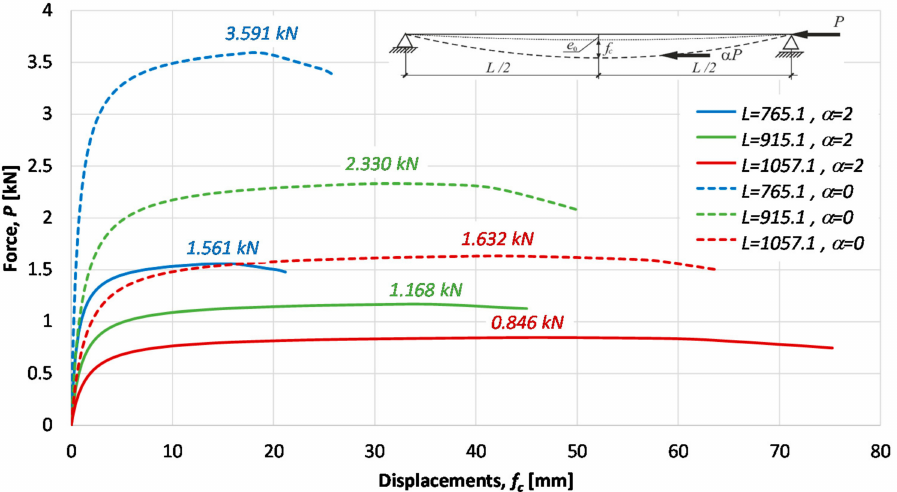
Figure 17. Load deflection paths obtained numerically for the initial bow imperfection of amplitude e 0 = L